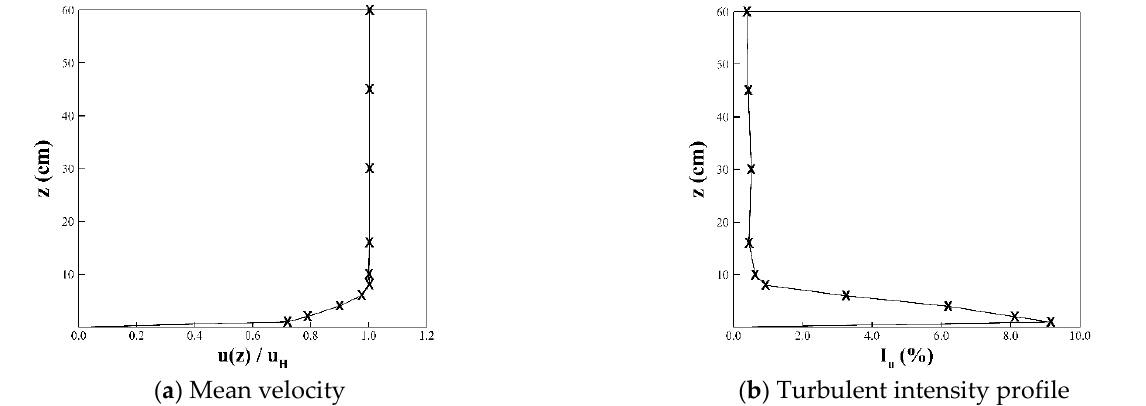
Figure 5. Velocity profiles of the oncoming flow in the experiments.